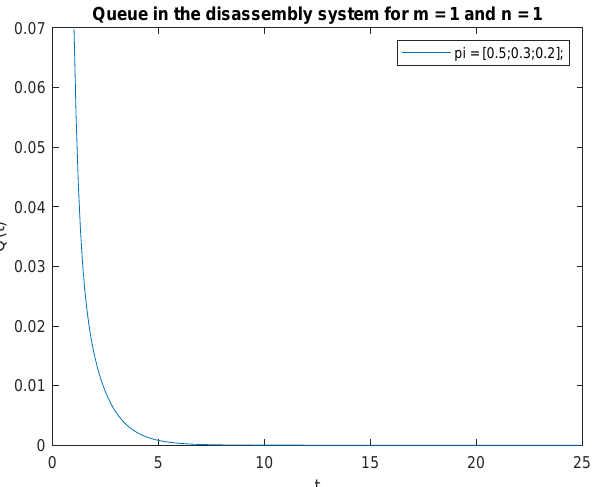
Figure 21. Impact of traffic load described by p i = { 0.5,0.3,0.2 } on P { X ( t ) = m = 1 | X ( 0 ) = n = 1 } for λ = 4.